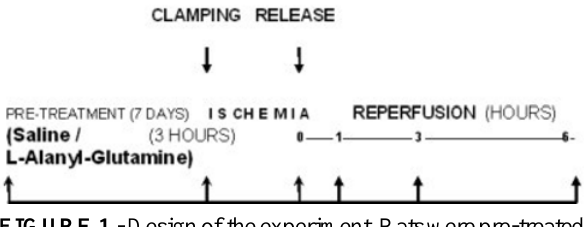
FIGURE 1 - Design of the experiment. Rats were pre-treated with Saline 2.0 mL or L-Ala-Gln 0.75mg Kg -1 at 7 AM during 7 days by gavage. One-hour after last gavage all rats were submitted to 3-hour hind limb ischemia (left iliac artery clamping). After 3 hours the clamp was removed. Samples were colleted at the end of the ischemia (0h) and during reperfusion (1, 3 and 6